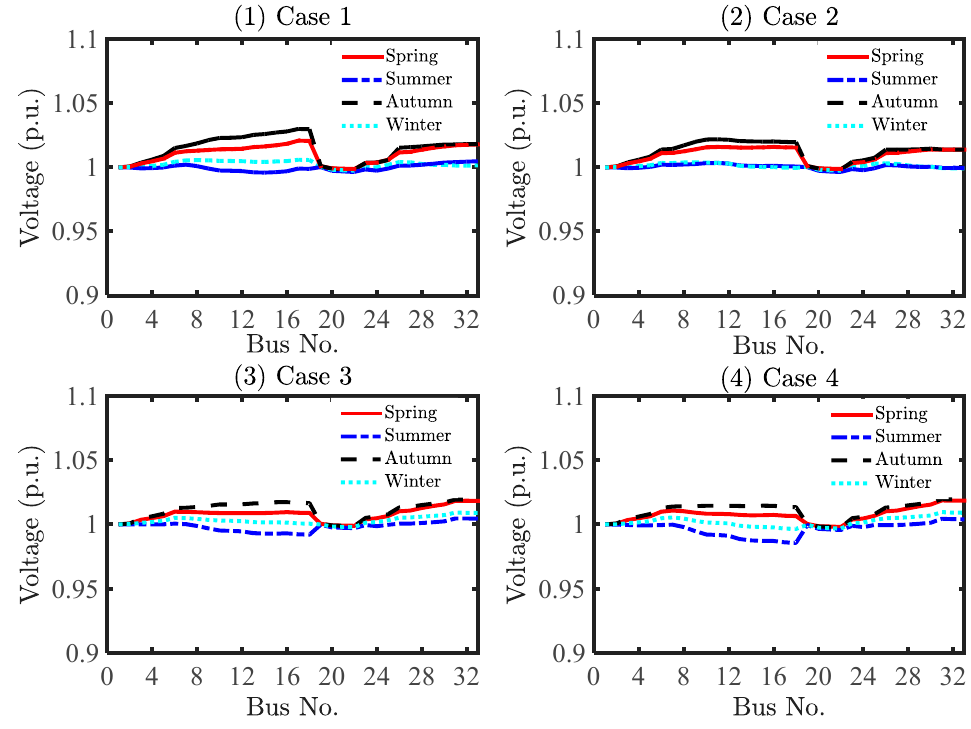
Figure 9. Voltage of Buses in the four cases in typical days.